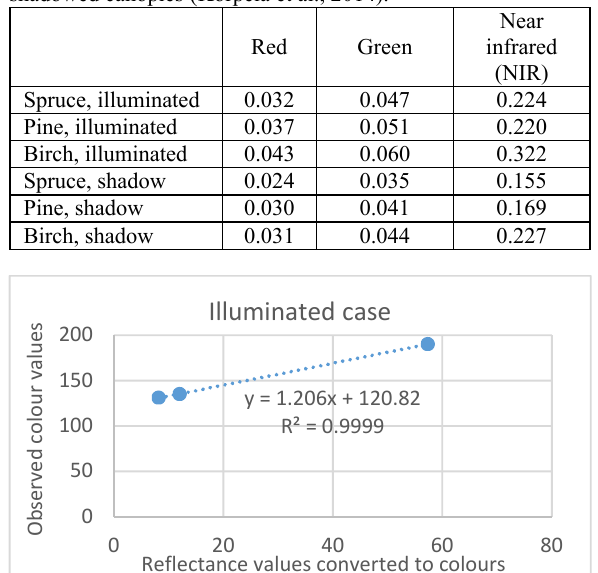
Figure 1. The regression for finding coefficients of a linear transformation in the illuminated case. The blue dots from left to right correspond to colours red, green and NIR, respectively.